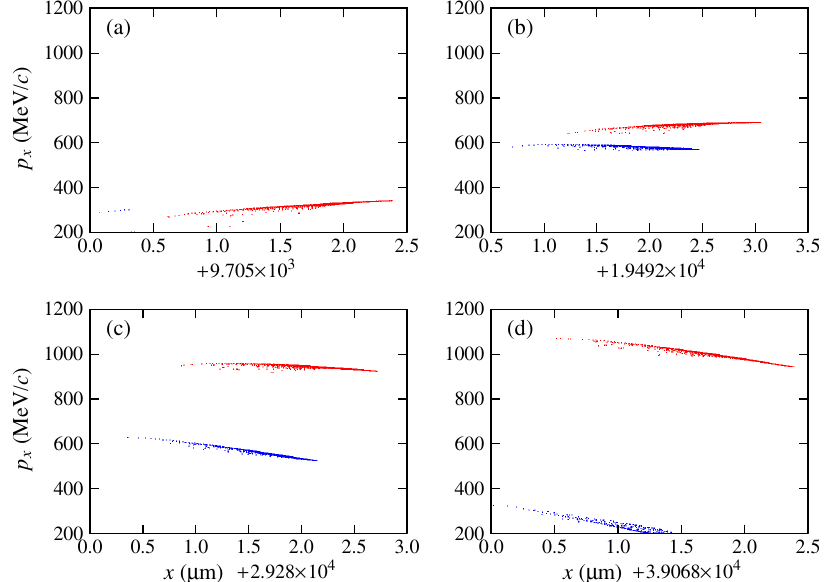
FIG. 3. Longitudinal phase space of the particles, at (a) 9.7 mm, (b) 19.5 mm, (c) 29.3 mm, and (d) 39.1 mm of propagation. The normal dispersion case is shown in blue and controlled dispersion in